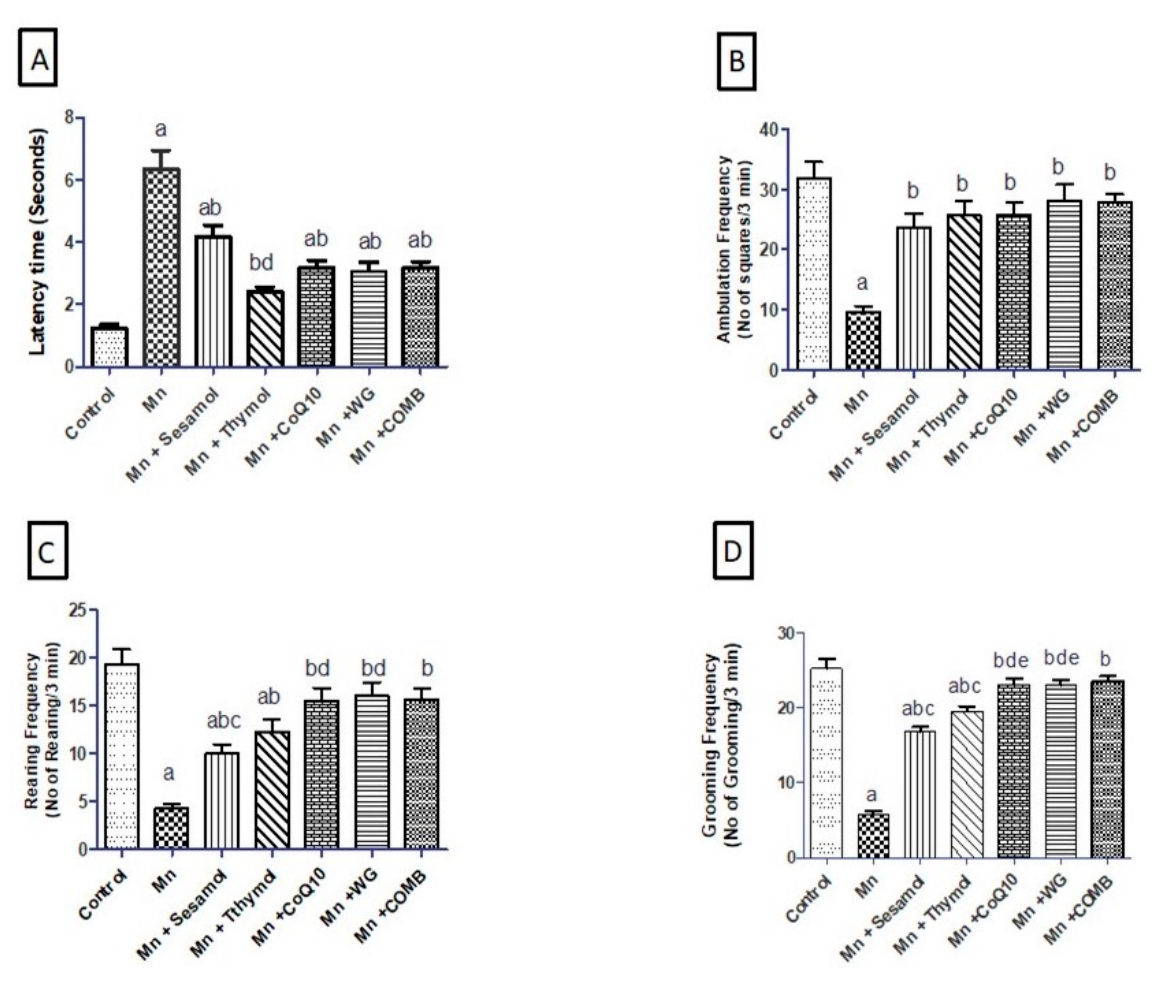
Figure 1. Effects of sesamol, thymol, CoQ10, wheat grass, or their combination on motor functions in open-field test of rats treated with MnCl 2 . ( A ) Latency time, ( B ) Ambulation frequency, ( C ) Rearing frequency, and ( D ) Grooming frequency. Values are means of 12 rats ± S.E.M, as compared with control (a), Mn (b), COMB (c), sesamol (d), and thymol (e) groups. One-way ANOVA with post-test Tukey’s multiple comparison assessed the statistical differences between the various groups, p -value < 0.05.